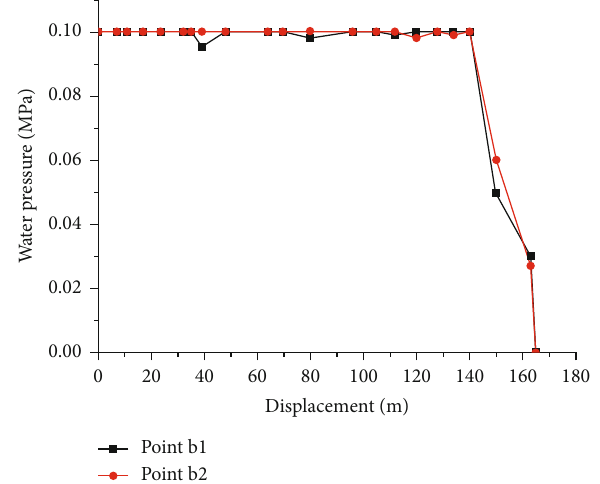
Figure 12: Relation curve between displacement and water